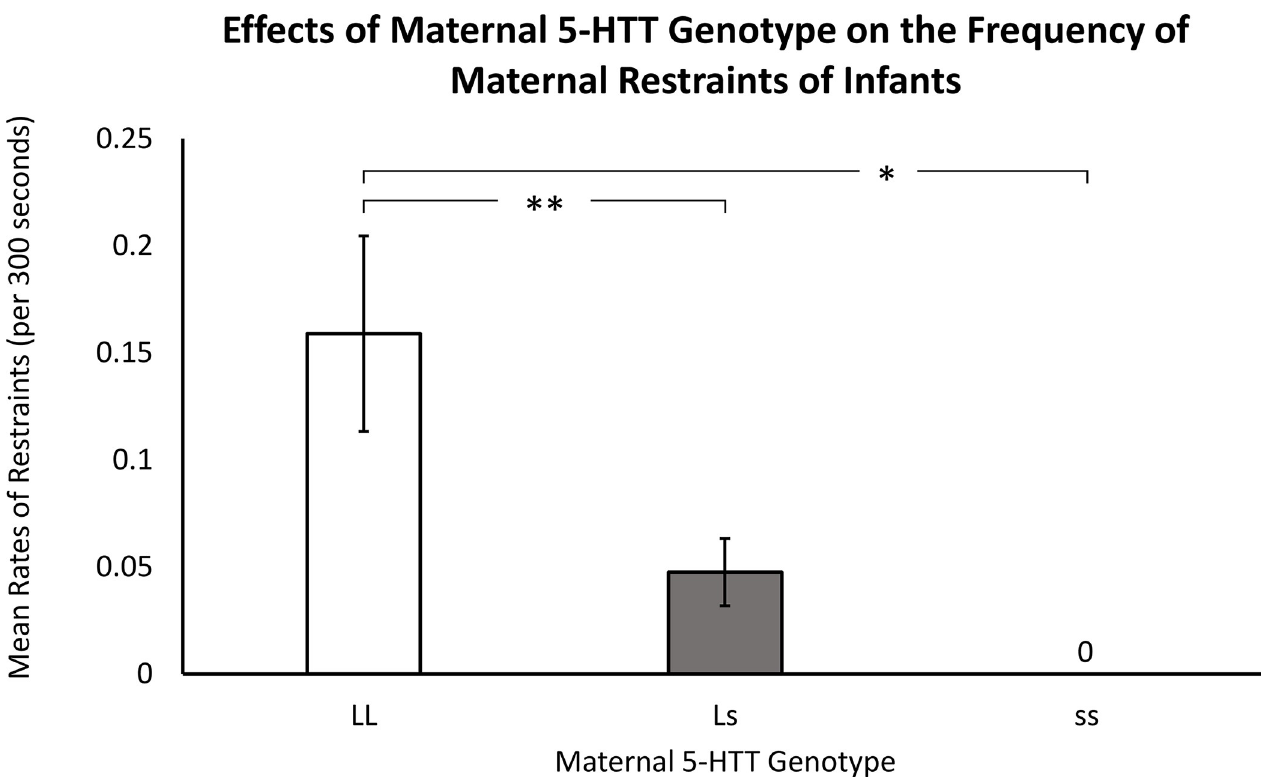
Fig 2. Effects of maternal 5-HTT genotype on the frequency of maternal restraints of infants. When compared to heterozygous mothers and mothers that were homozygous for the s allele, mothers homozygous for the L allele exhibited the highest rates of maternal restraints ( p = .02). Mothers that were homozygous for the L allele restraining their infants more, on average ( p < .01), when compared to heterozygous mothers and mothers homozygous for the s allele ( p < .03). Mothers that were homozygous for the s allele did not exhibit any restraints, indicating a robust effect with each addition of the s allele. White bars indicate mothers that were homozygous for the L allele, gray bars indicate heterozygous mothers, and black bars indicate mothers that were homozygous for the s allele. Error bars are standard errors.